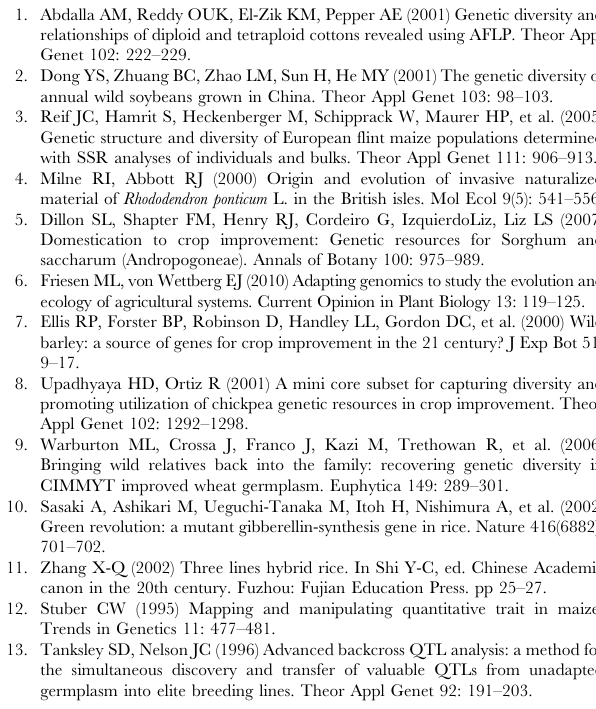
Table S5 Effect of allelic distribution on multi-QTL mapping in the fourth simulation experiment (200